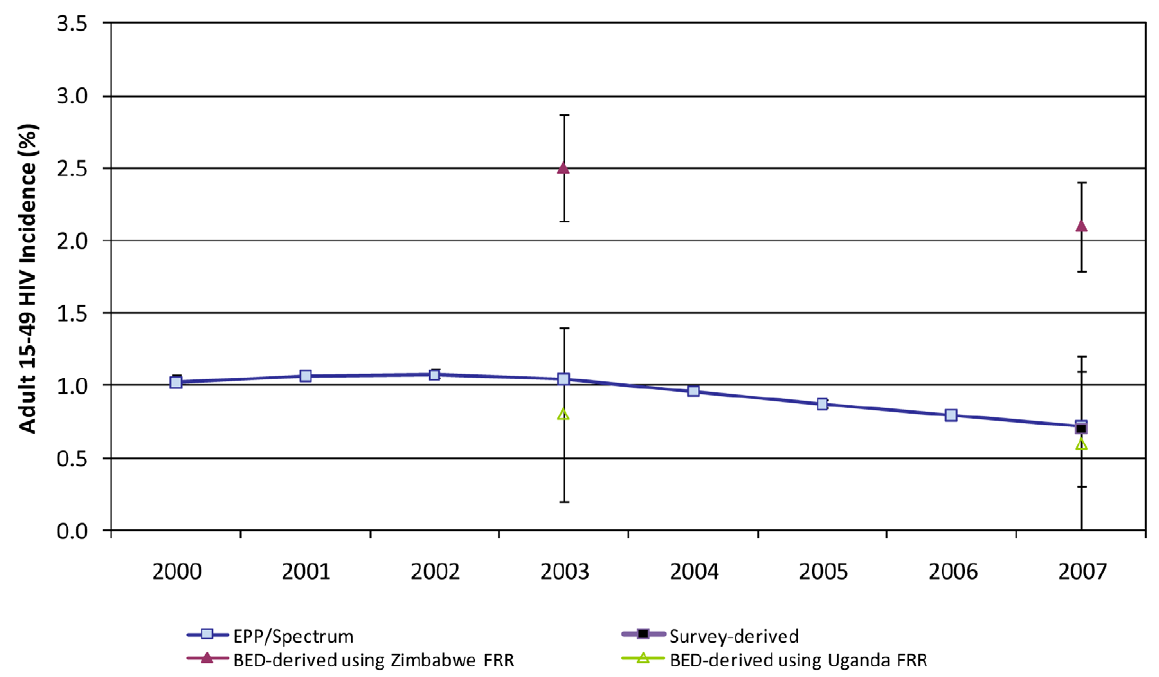
Figure 2. Trends in HIV prevalence among young women aged 15–24 years attending antenatal clinics in Kenya, 2000–2005.